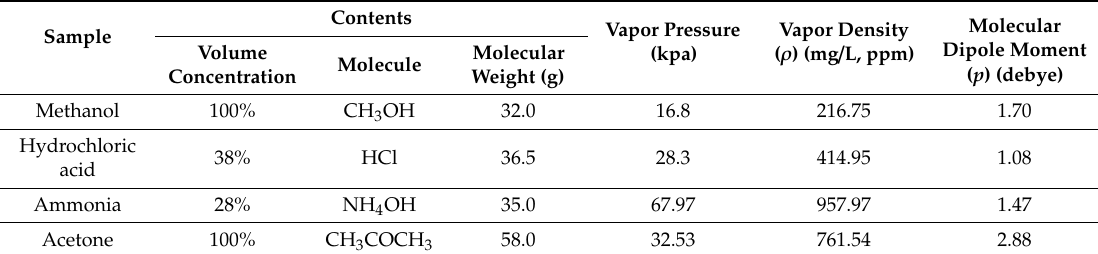
Table 1. Molecular properties of gas samples